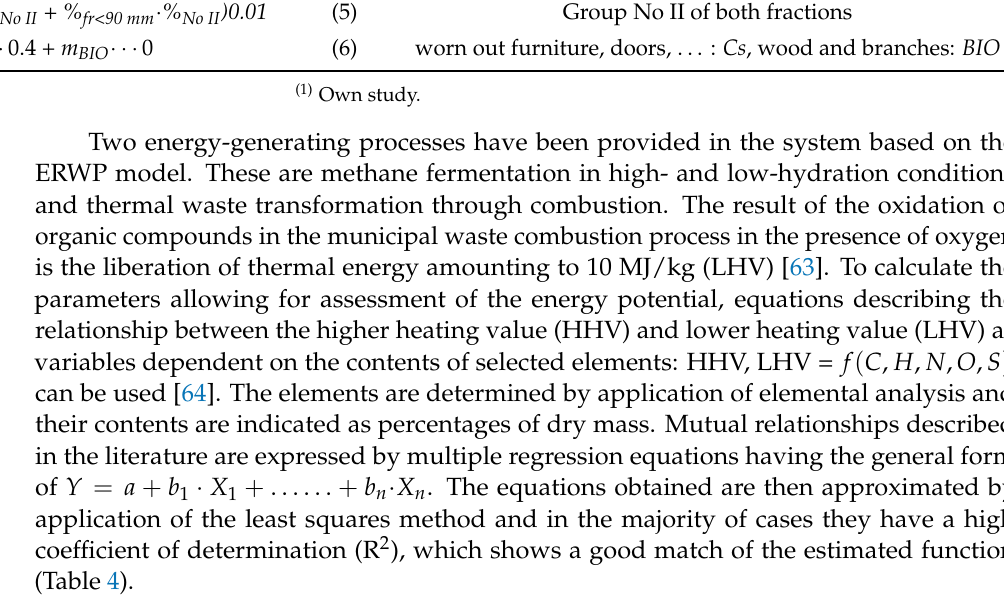
Table 4. Equations used to determine HHV and LHV in MJ/kg depending on the chemical composition.